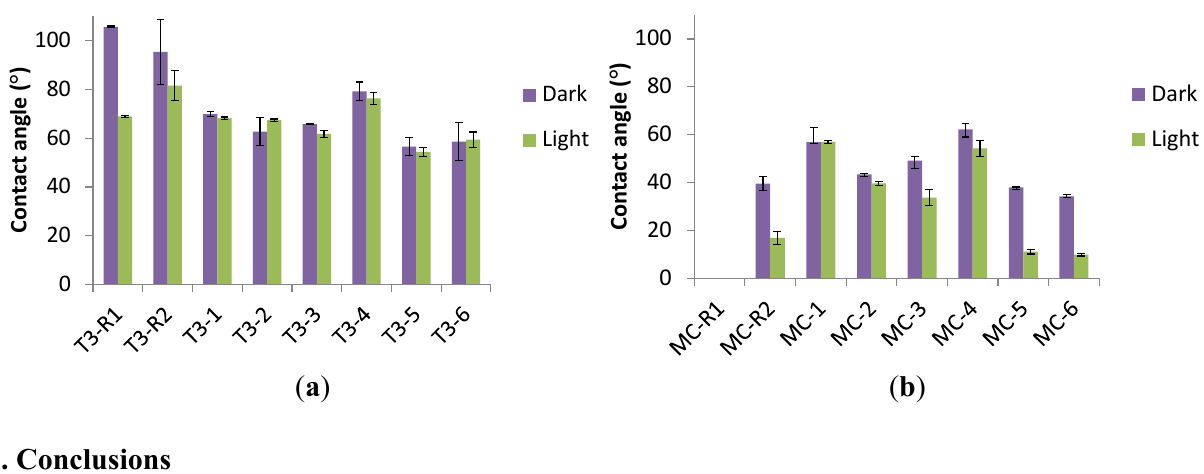
-Mo (U2); and ( b ) TiO (MC) 2 2